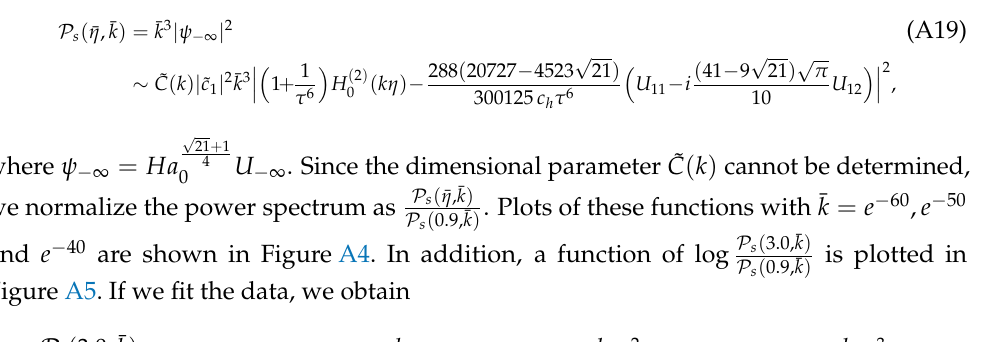
3.0,¯ k ) as a function of log k P t ( 0.9,¯ k )